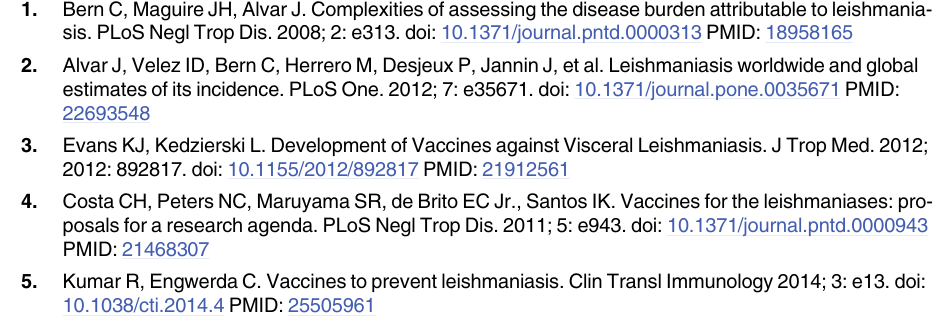
S1 Fig. Dose–dependent PLGA NPs effect on DCs maturation. Analysis of (A) CD40 and (B) CD86 expression (MFI values) on DCs pulsed with PLGA NPs at different doses with flow cytometry. Results are expressed as mean±SD (n = 3) from three independent experiments. (cid:3) p < 0.05, (cid:3)(cid:3) p < 0.01, (cid:3)(cid:3)(cid:3) p < 0.001 were assessed by one-way ANOVA and Tukey’s multiple com- parison tests. (TIF) S2 Fig. Effect of PLGA NPs-pulsing on DCs functional maturation. (A) Representative his- tograms and (B) dot plots showing CD40, CD80, CD86, MHCI and MHCII molecules expres- sion and (%) of IL-12-producing DCs after treatment with PLGA NPs.